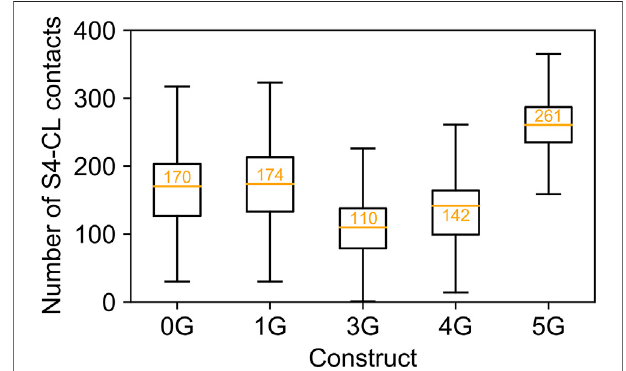
FIGURE 5 | Contacts between S4 and C-linker. Number of contacts between S4 and C-linker in MD simulations of each construct. The values are displayed as a standard boxplot, with the difference that the orange line indicates the mean (additionally depicted as orange